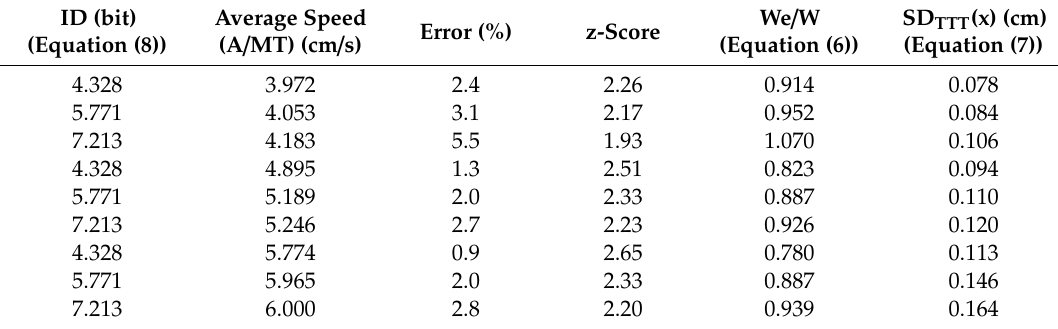
Table 2. ID, Speed, We and SD(x) values for the Tunnel Traveling Task.